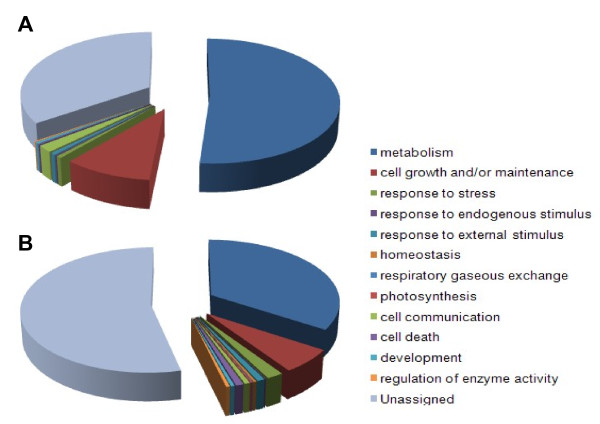
Gene Ontology (GO) annotation of fungal (A) and plant genes (B) expressed during their interaction. The ratio of hits to Biological Process is indicated. Fungal and rice ESTs were used to search matching ORFs from genome and full-length cDNA sequences, respectively. Translated ORF sequences were subjected to InterPro and GO analyses.